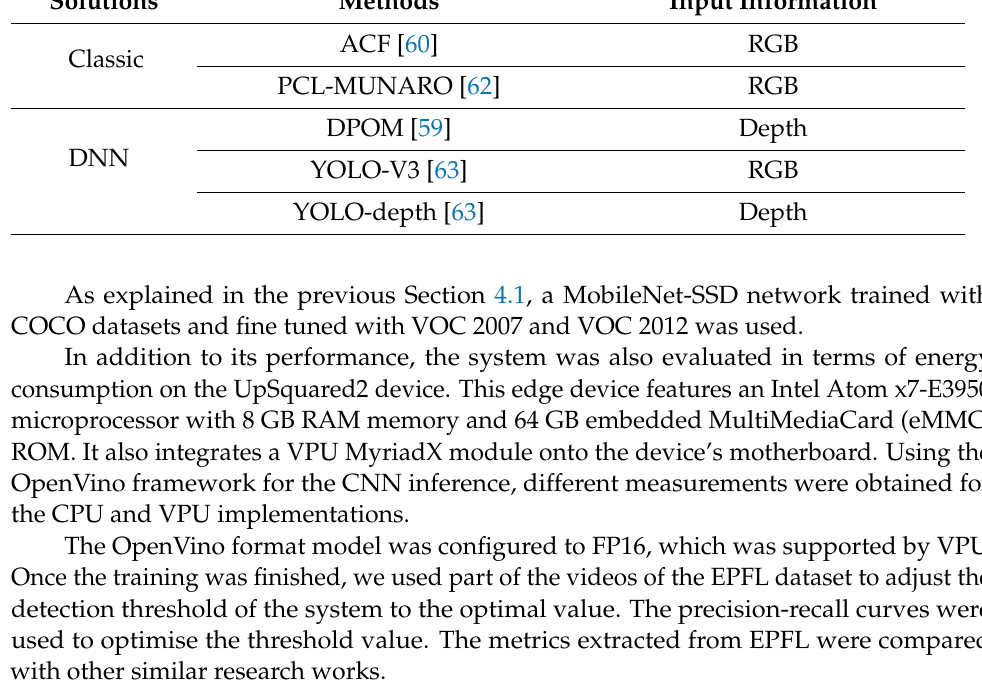
Table 2. Evaluated state-of-the-art methods.